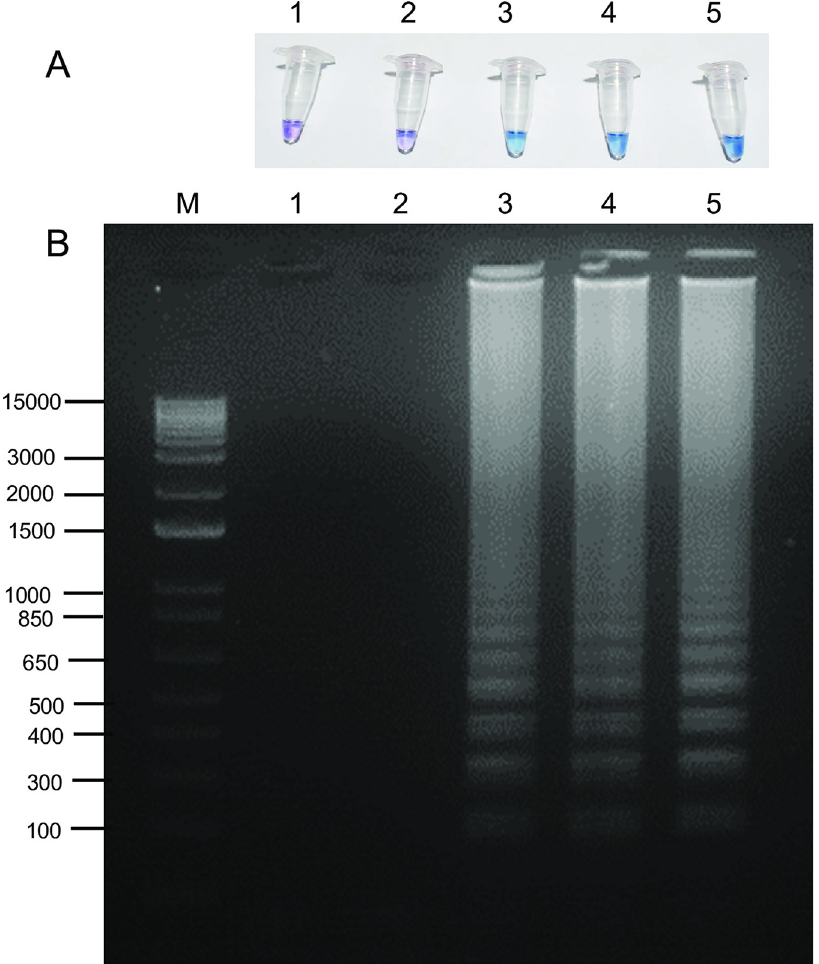
Fig 2. Detection of Wolbachia w AlbB gene in different mosquito species using LAMP assay with HNB indicator (A) and ethidium bromide-stained gel (B): (1) no template control, (2) wild-type Aedes aegypti (AegW, Aae-JJ), (3) Wobachia trans-infected Thai Ae . aegypti (AegB, w AlbB-TH), (4) Aedes albopictus (Alb, Aal-CH), and (5) Culex quinquefasciatus (Cq-BK). M is 1 kb plus DNA Ladder from Invitrogen. The condition for LAMP reaction was 6.4 units of Bst 2.0 DNA polymerase, 65˚C for 60 min and 80˚C for 10